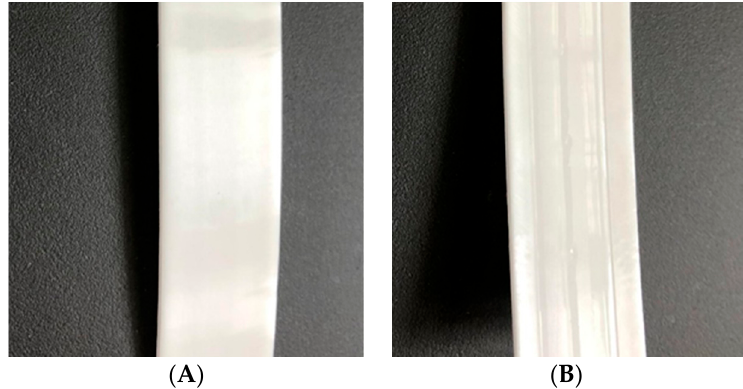
Figure 8. Extruded plate with ( A ) smooth front side and ( B ) back side with slight inhomogeneity.